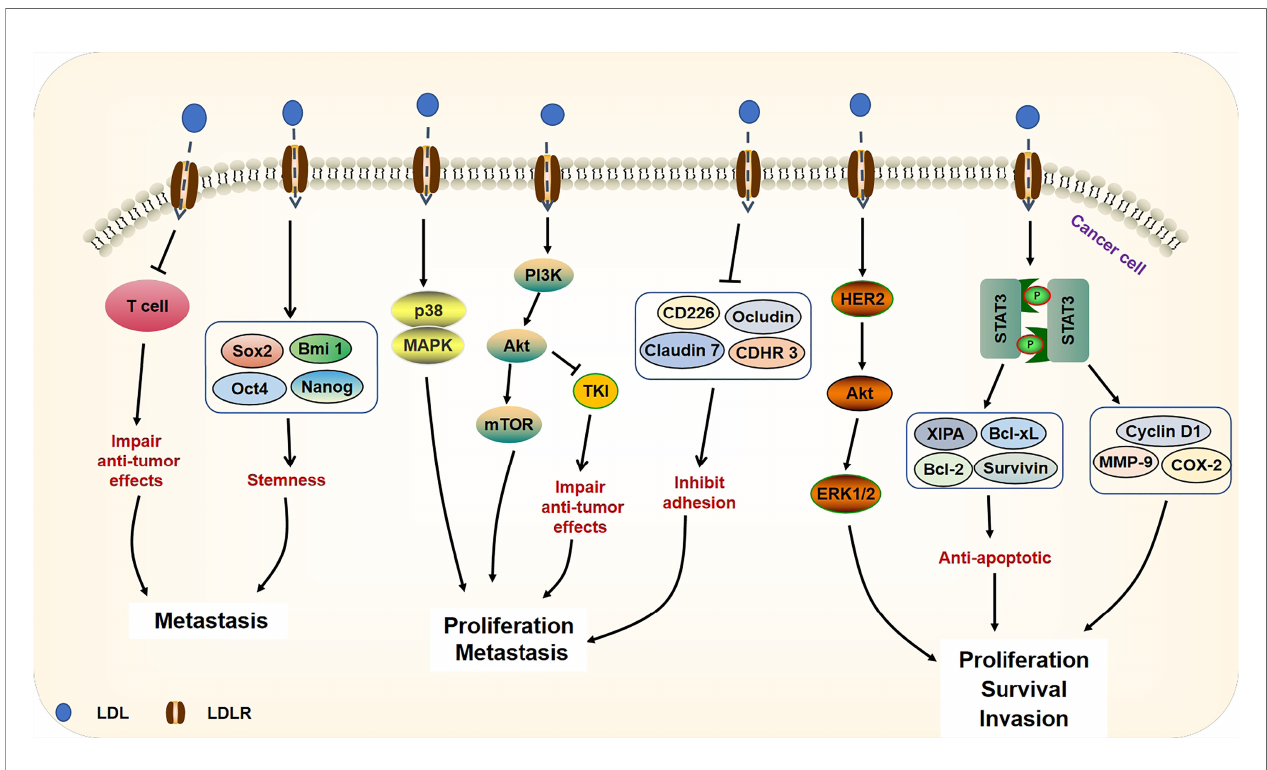
FIGURE 2 | Signaling pathways of LDL on cancer progression. The accumulation of LDL can damage the anti-tumor effects of T cells. Through up-regulating the expressions of stemness genes (Sox2, Bmi 1, Oct4, Nanog), LDL supports cancer metastasis. LDL activates p38 and MAPK as well as PI3K/Akt/mTOR signaling pathways, leading to cancer proliferation and metastasis. Besides, through activation of PI3K/Akt signaling, LDL compromises the TKI anti-tumor ef fi cacy against cancer cells. LDL decreases adhesion molecules (CD226, Ocludin, Claudin 7, CDHR3), which help cell migration. Moreover, LDL can activate HER2/Akt/ERK signaling pathway and up-regulate STAT3 target genes (including anti-apoptotic genes and MMP-9, Cyclin D1, COX-2) expression, which promote the survival and invasion of cancer